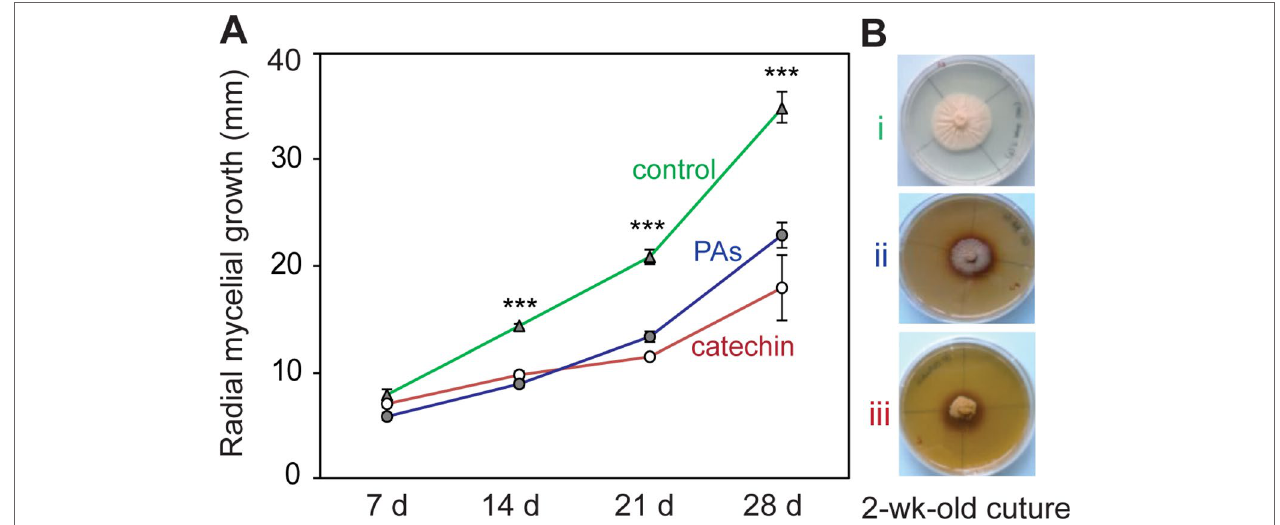
FIgURe 2 | Catechin and proanthocyanidins (PAs) have antifungal activity against P. populi . (A) Radial mycelial growth of the fungus in culture medium supplemented with catechin or PAs at in planta concentrations. (B) Representative pictures of the fungus growing in culture media at 14 days: (i) control medium, (ii) PA medium (2 mg ml -1 ),and (iii) catechin medium (2 mg ml -1 ). Data were analyzed using Student’s t-test (***, p < 0.001). Data presented are mean ± SE (n = 7). d, day.